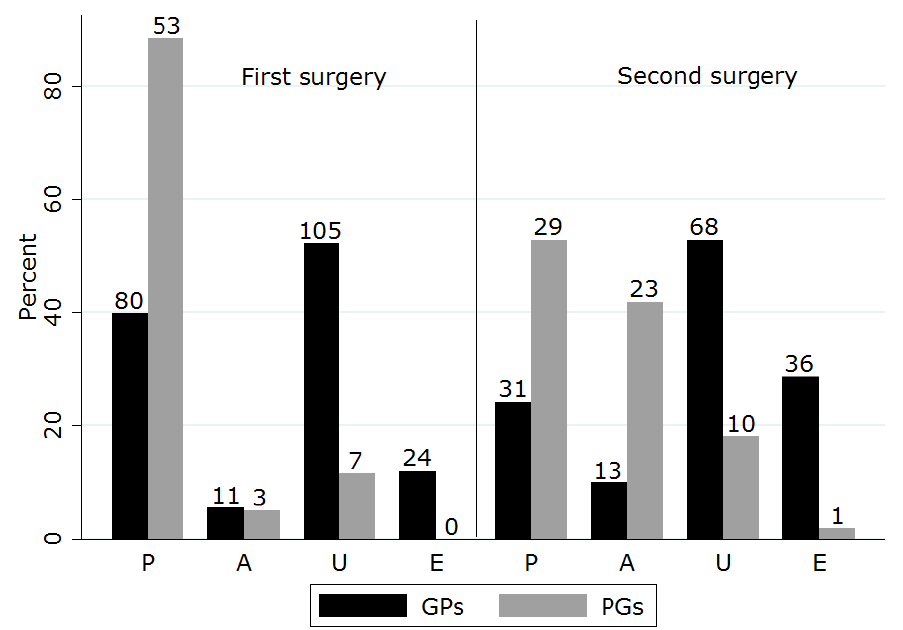
Figure 1. Surgical options nominated for treatment of prolapsed nictitans gland on first occurrence and for recurrence (P, pocket suggestion; A, anchoring suggestion; E, excision; U, unspecified replacement surgery suggestion).